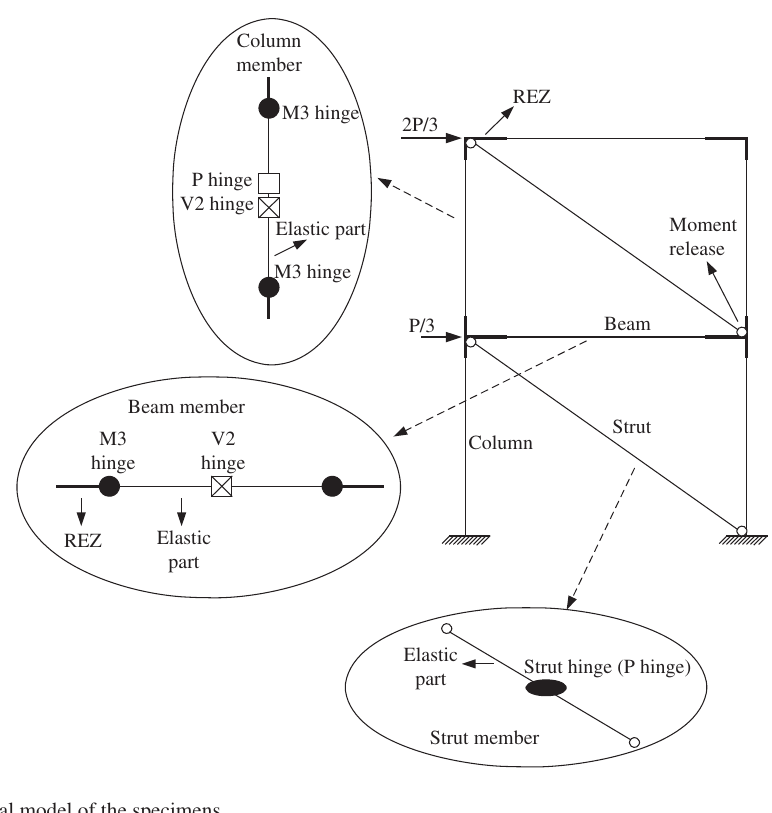
Figure 19 Mathematical model of the